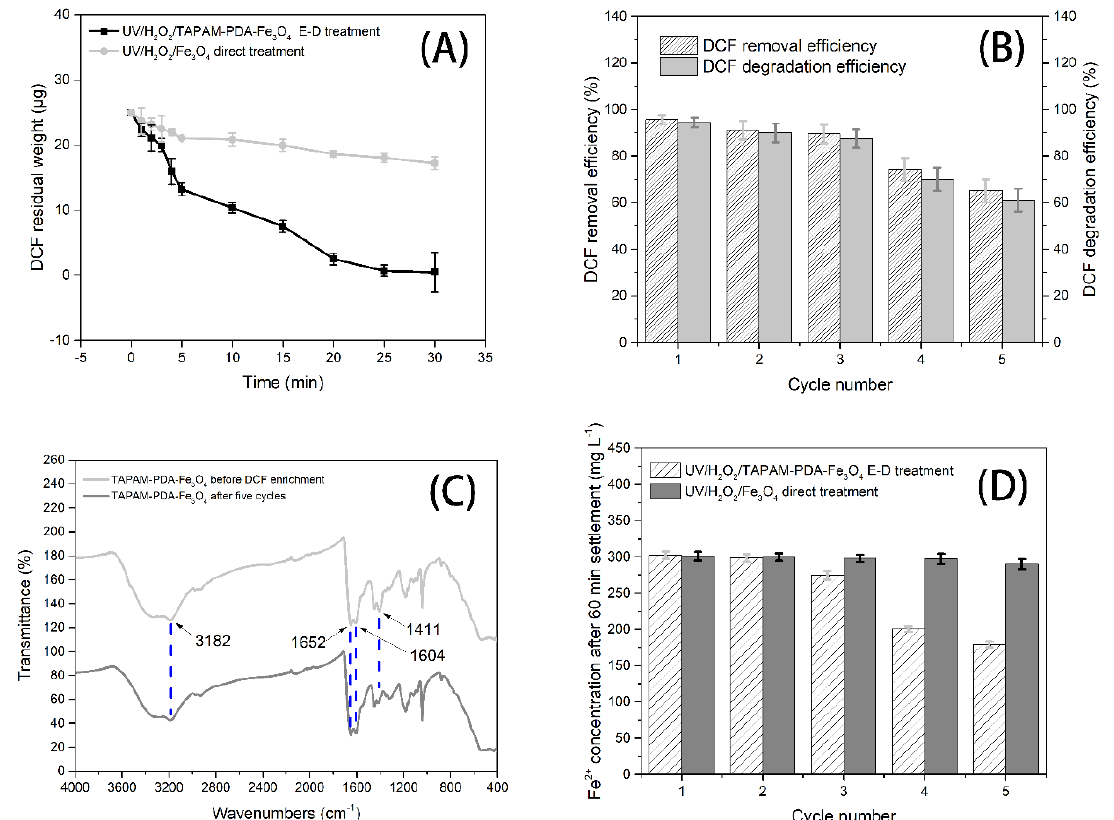
Figure 11. DCFS residual weight in the initial cycle ( A ), DCFS removal and degradation efficiency ( B ), FT-IR spectra of virgin and used TAPAM-PDA-Fe 3 O 4 ( C ) and the concentration of Fe 2+ in solution ( D ).